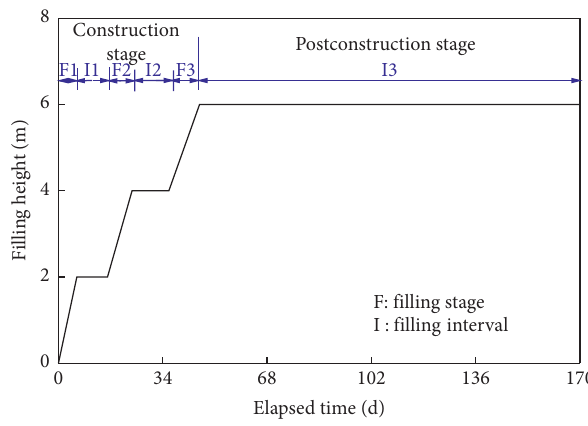
Figure 2: Filling process of the